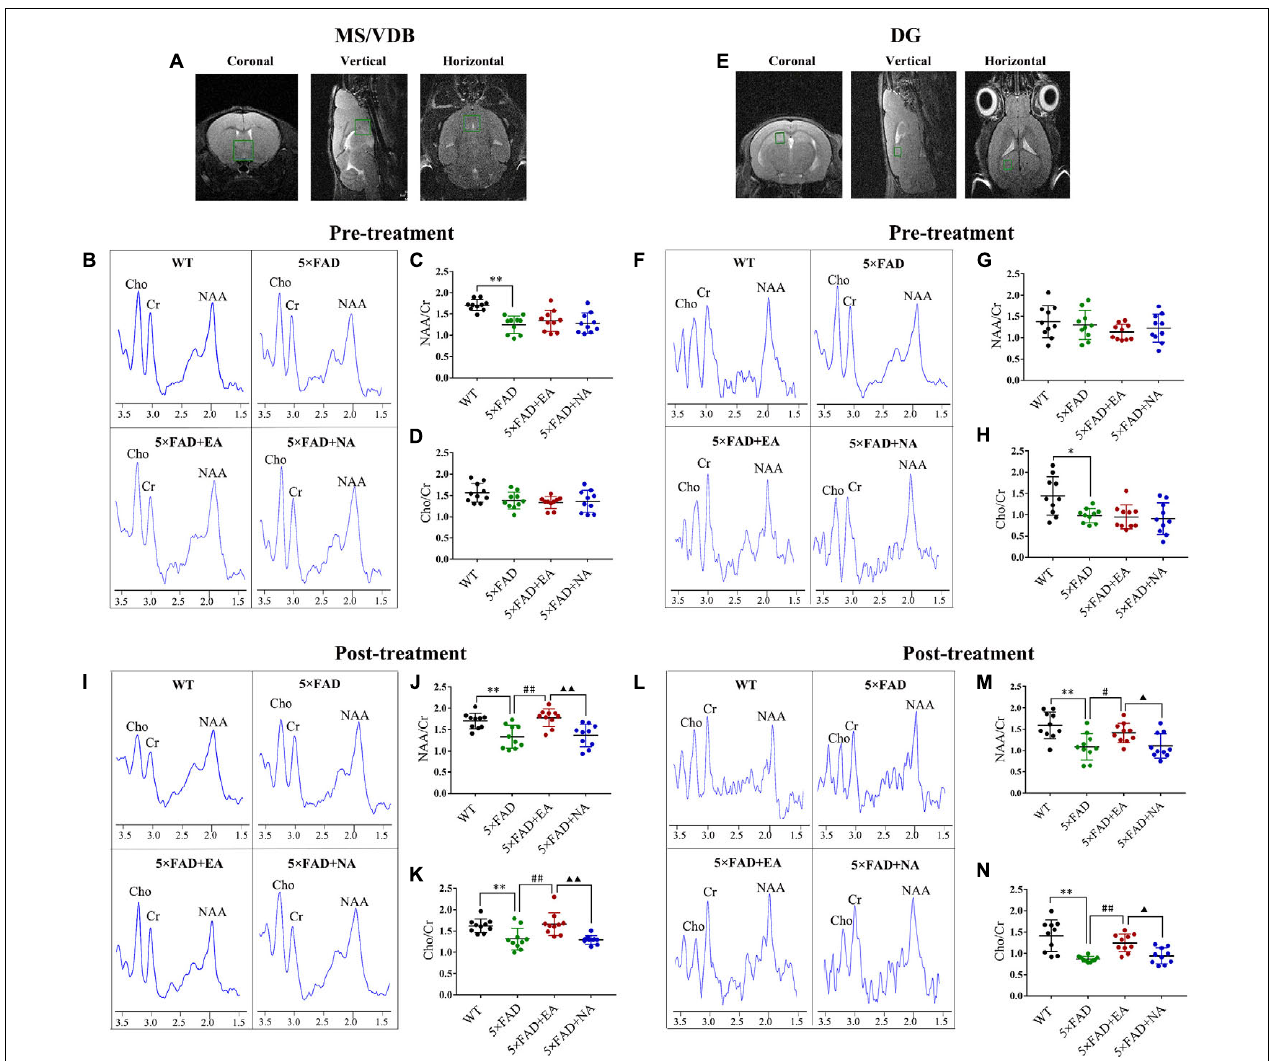
FIGURE 4 | Electro-acupuncture (EA) treatment regulates brain metabolites in medial septal and vertical limb of the diagonal band (MS/VDB) and dentate gyrus (DG) by 1 H MRS. (A,E) The location of the MS/VDB and DG on the T2-weighted scan is the 1 H MRS shimming region. (B,F,I,L) 1 H MRS exhibits N-acetylaspartate (NAA) peak at 2.02 ppm, choline (Cho) peak at 3.2 ppm, and creatine (Cr) peak at 3.05 ppm in MS/VDB and DG of groups pre and post-treatment. The ratio of NAA/Cr in MS/VDB (C,D) and Cho/Cr in DG (G,H) were significantly decreased pre-treatment, and the ratios of NAA/Cr and Cho/Cr in MS/VDB (J,K) and DG (M,N) were significantly increased in the 5 × FAD + EA group. Data are represented as mean ± SD, n = 10/group, and each circle represents a mouse (* p < 0.05 and ** p < 0.01 vs WT group; # p < 0.05 and ## p < 0.01 vs 5 × FAD group; (cid:78) p < 0.05 and (cid:78)(cid:78) p < 0.01 vs 5 × FAD + EA